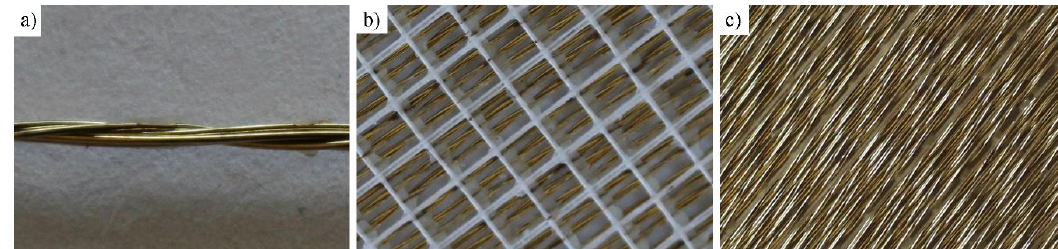
Figure 1. View of steel cord ( a ), low- ( b ), and high-density ( c ) ultra-high-tensile-strength (UHTS) steel textiles.